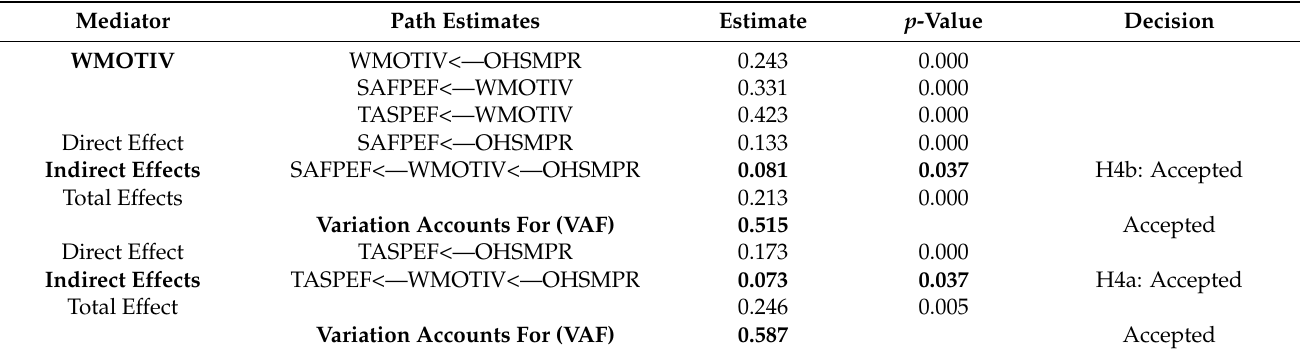
Table 9. Mediation Analysis.